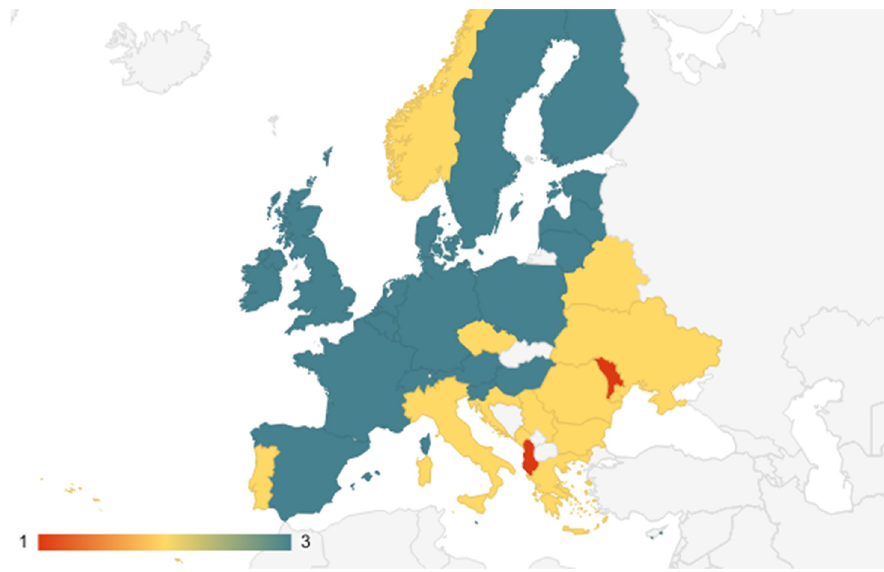
Figure 5. The clusters map.